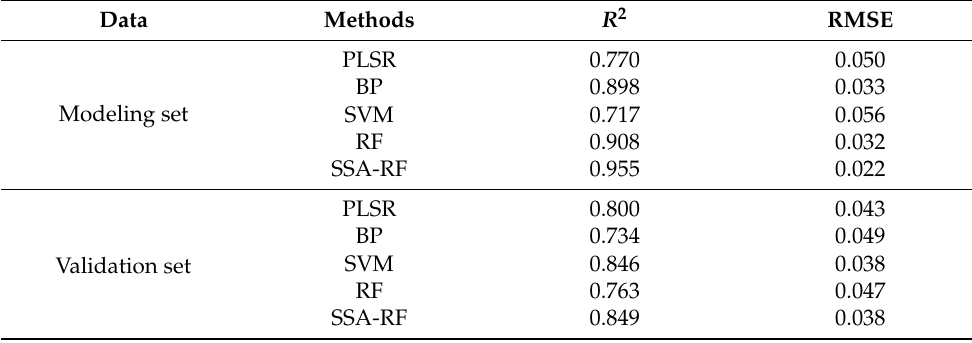
Table 5. Comparison of estimation results of different